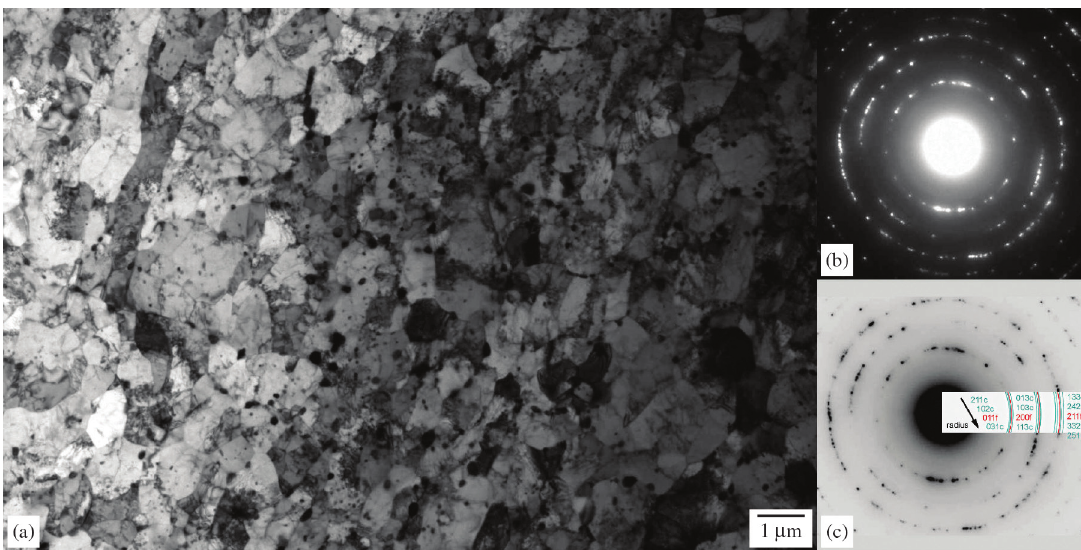
Figure 5. Thin foil TEM micrograph obtained after warm thermomechanical processing. Typical panoramic view showing formation of equiaxed and elongated grains of ferrite and particles of rounded cementite in (a) with its respective polycrystalline electron diffraction pattern in (b). Key diagram is presented in